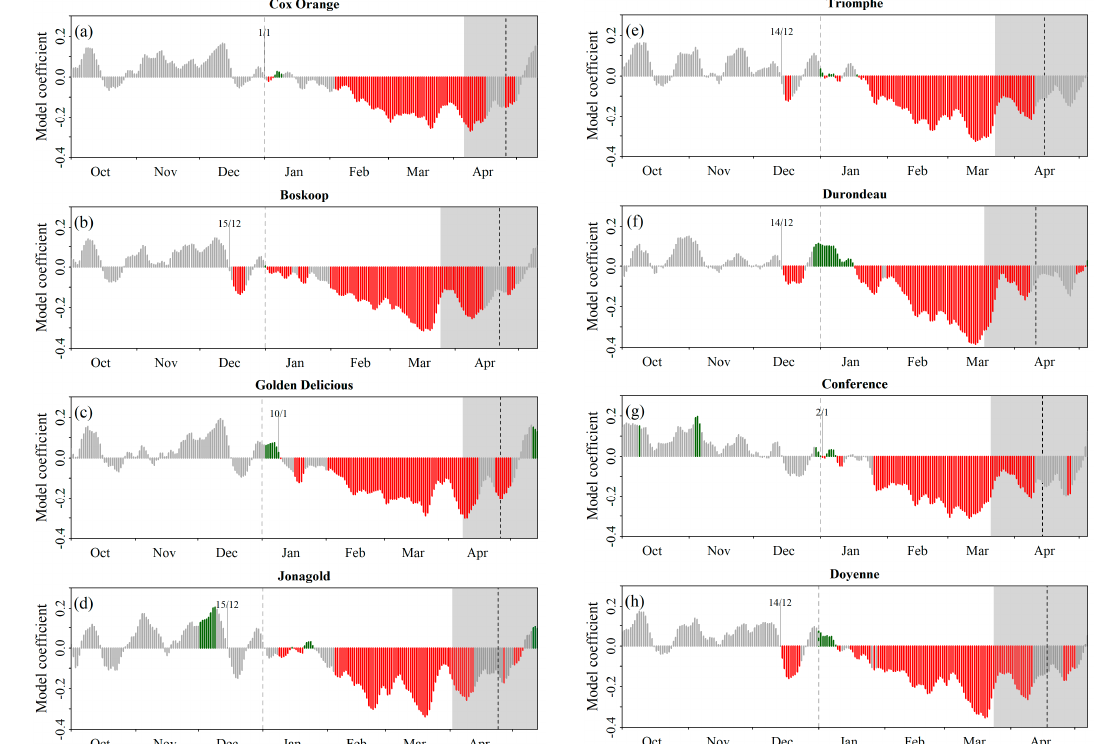
Figure 4. Results of the partial least square regression (PLSR) for selected cultivars of apple ( a – d ) and pear ( e – h ) during 68 years between the start date of flowering (BBCH61) and daily average temperatures during the dormancy. Green (positive) and red (negative) areas depict daily coefficients of the model (11-days running average daily mean temperature values) where the variable importance of the projection (VIP) value exceeds the threshold of 0.8, indicating that the corresponding variable was important for the model. In this figure, all years for which bloom date observations were available have been considered. The shaded area represents the range of observed bloom dates, the black dashed line within the shaded area the median value of the bloom date, and the grey dashed line the 1 January as reference. Labelled dates indicate the beginning of the forcing period.